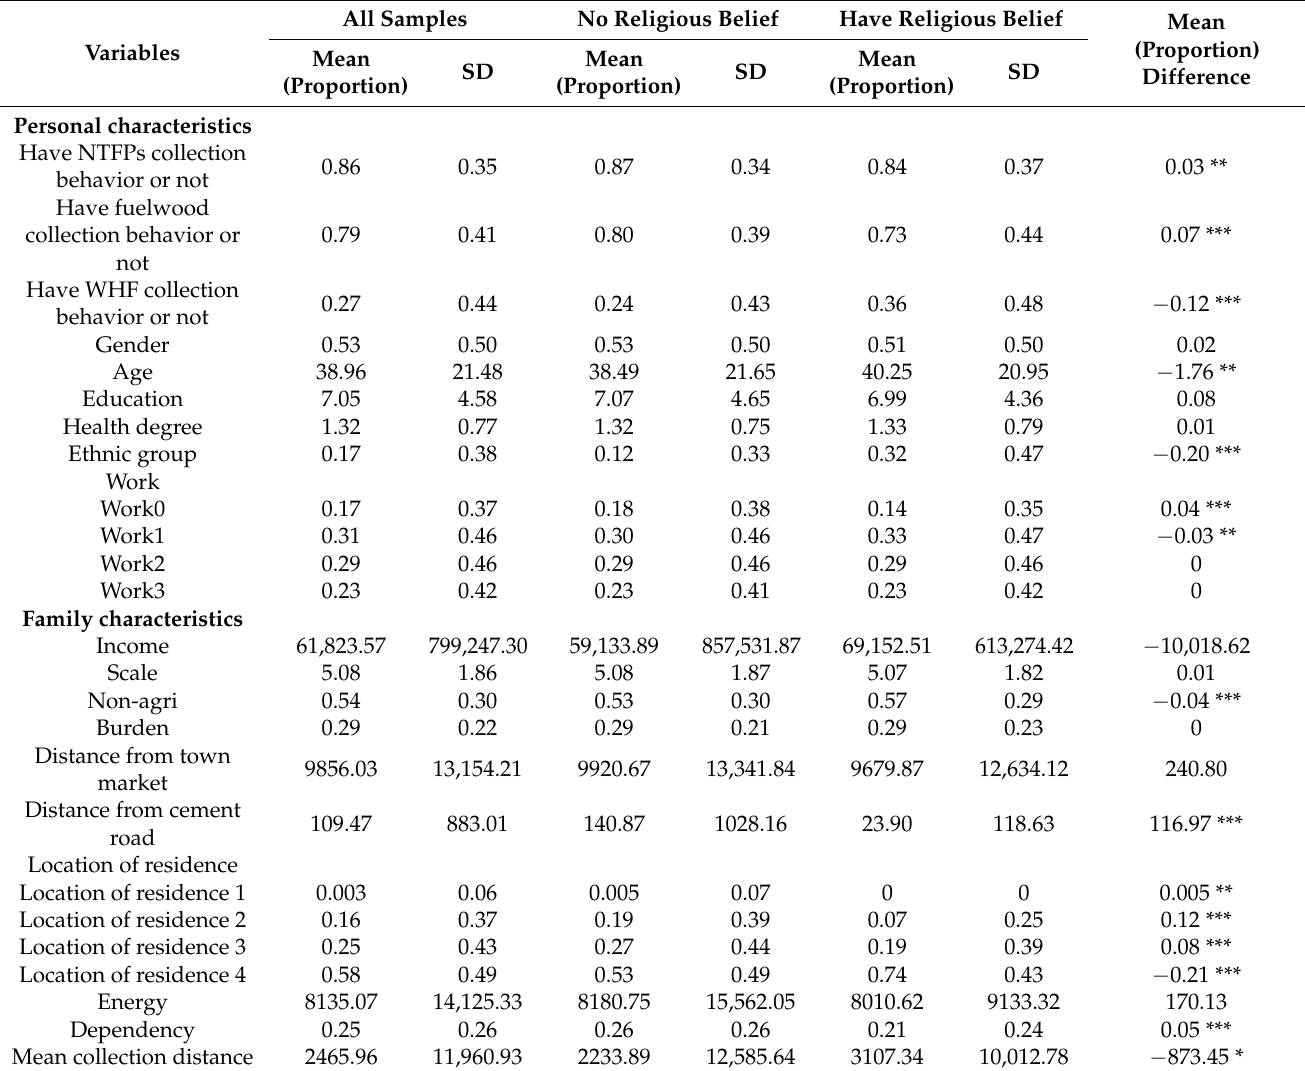
Table 4. Descriptive statistics of the main